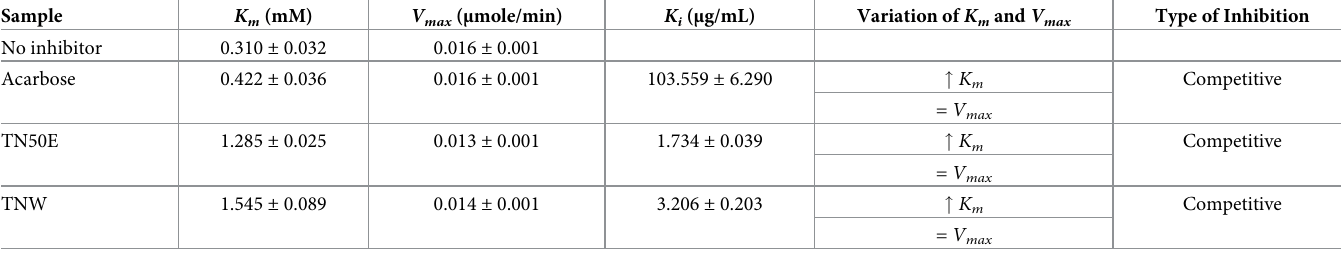
Values are expressed as mean ± standard